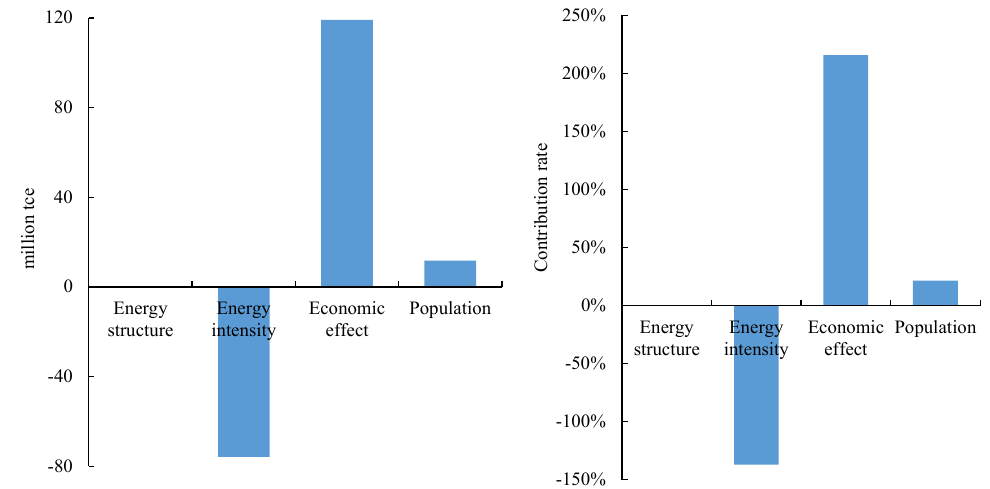
Figure 4. Cumulative contribution of energy consumption influencing factors in Zhejiang province. Data source: Authors’ calculations